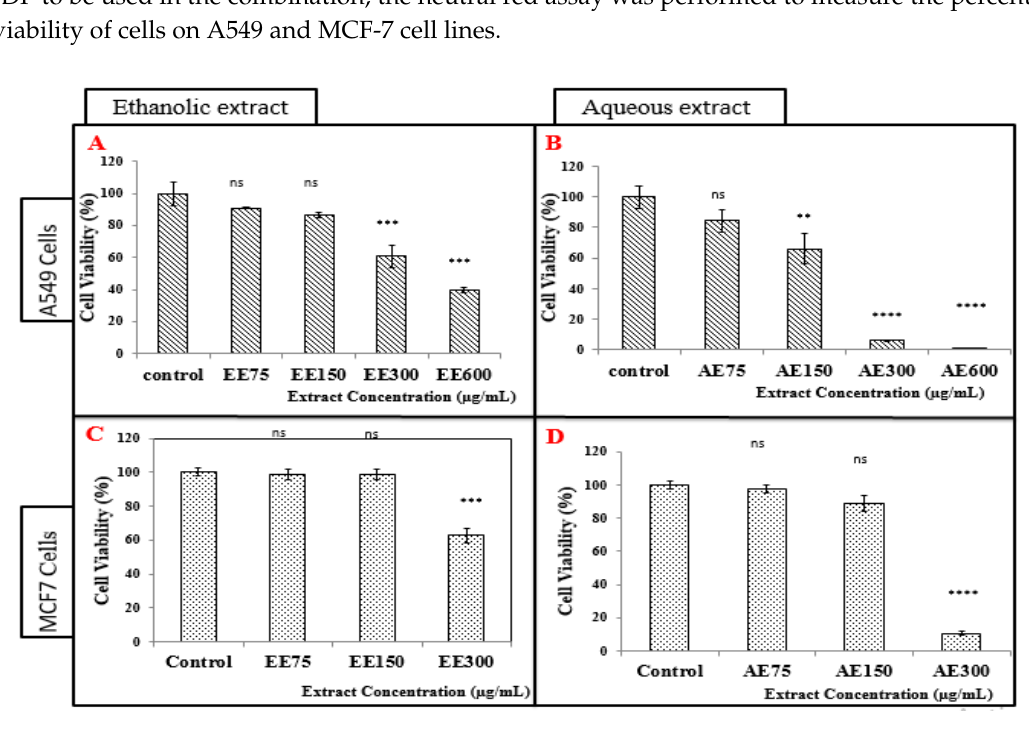
Figure 2. Cell viability of A549 and MCF-7 cell lines after treatment for 24 h with ethanolic extract (EE) and aqueous (AE). ( A ) Cell viability of A549 cells after treatment with increasing concentrations of ethanolic extract of E. camaldulensis for 24 h. ( B ) Cell viability of A549 cells after treatment with increasing concentrations of aqueous extract of E. camaldulensis for 24 h. ( C ) Cell viability of MCF-7 cells after treatment with increasing concentrations of ethanolic extract of E. camaldulensis for 24 h. ( D ) Cell viability of MCF-7 cells after treatment with increasing concentrations of aqueous extract of E. camaldulensis for 24 h (* p < 0.05, ** p < 0.01, *** p < 0.001, **** p < 0.001).